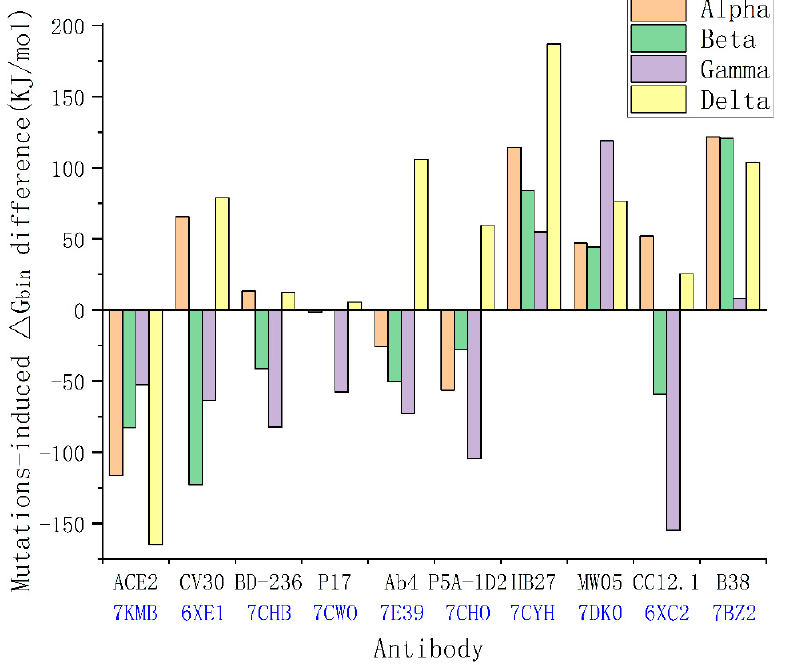
Figure 5. Mutation-induced ∆ G bin difference of the VOCs in the binding with ACE2 as compared to the original SARS-CoV-2, and mutation-induced ∆ G bin difference of the VOCs in the binding with antibodies as compared to the original SARS-COV-2. The corresponding PDB IDs are added in the figure.